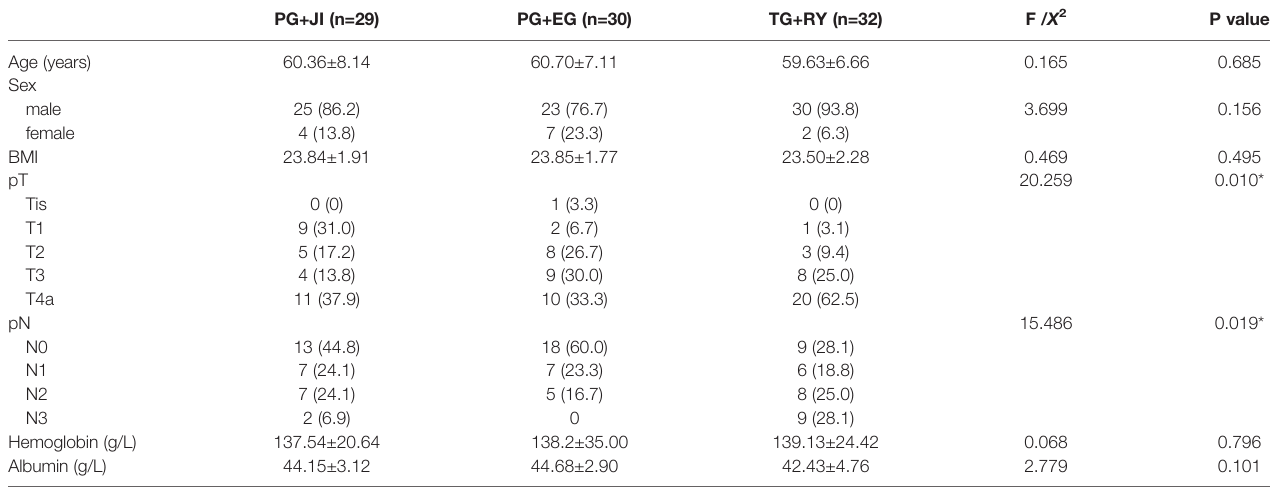
TABLE 1 | Patient characteristics.